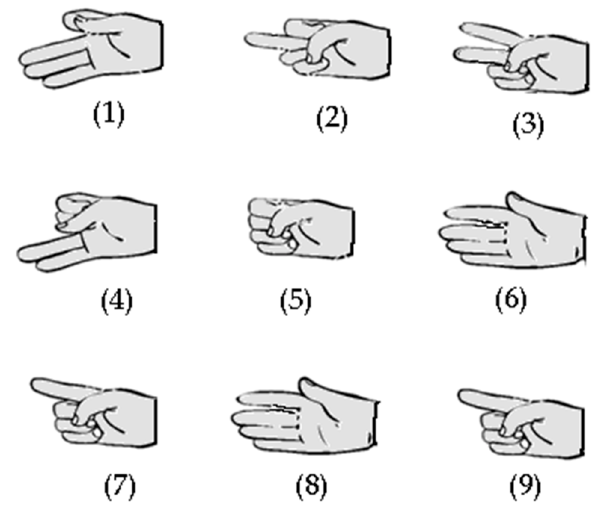
Figure 3. Hand gestures (1 to 9) used in exercises one and two. Those gestures were designed to test the capability of IGlove system for recognizing finger movements, using sensors on the thumb, index, and middle fingers.